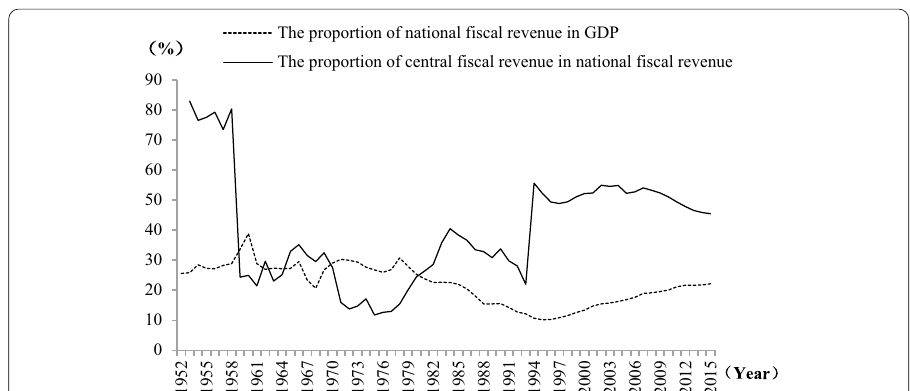
Fig. 2 the trend of “two proportions” since the founding of new China. Data source: Ministry of Finance of the People’s Republic of China, 2017, China Public Finance Yearbook (2016), Beijing: China Public Finance Press. Note: According to the calculation by the usual method, the national fiscal revenue does not include extra-budgetary income. The main reason for this exclusion is that due to the statistical changes, a large amount of the income of enterprises and institutions may be included or excluded as extra-budgetary income, and thus this income is